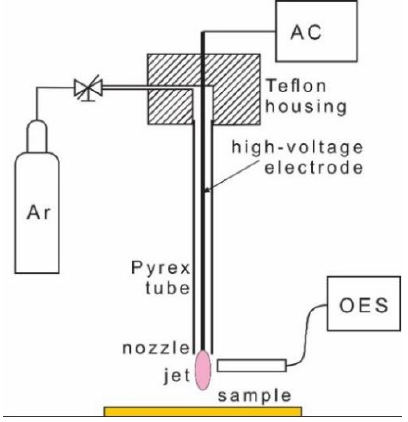
Figure 1. Schematic drawing of the APPJ system used for polymer surface modification.